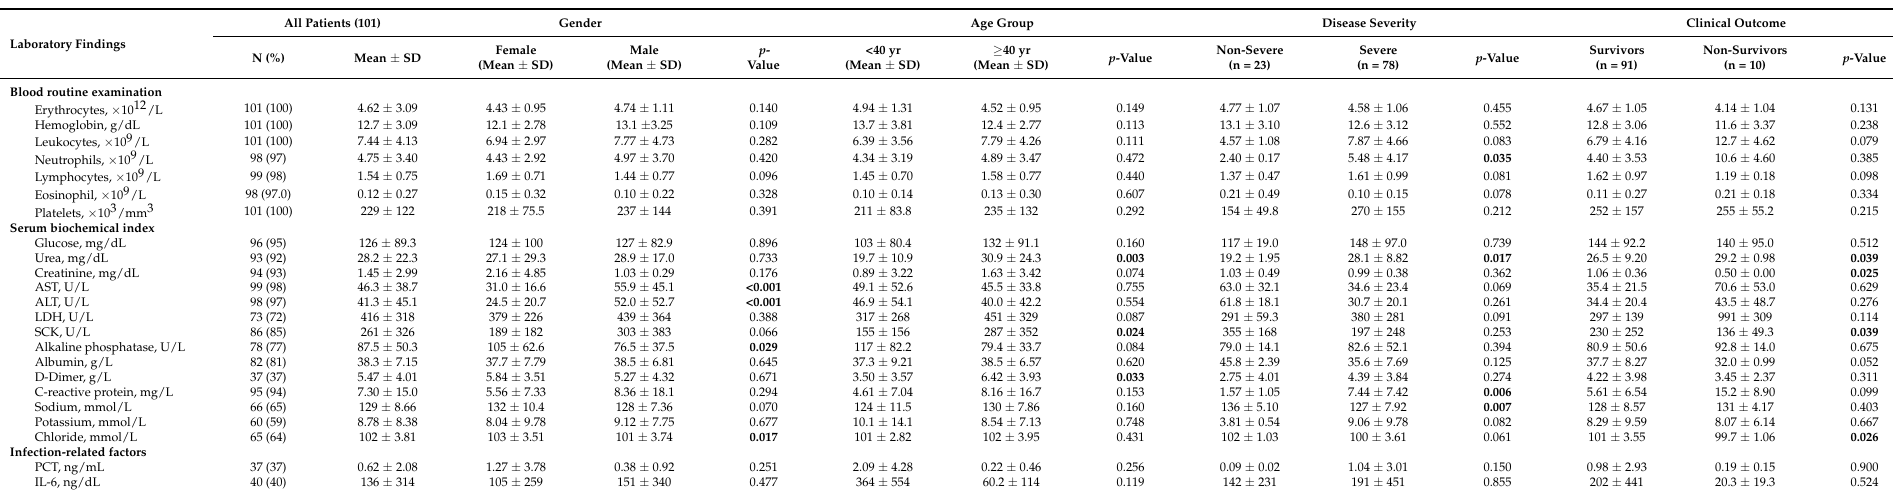
Table 2. Baseline laboratory parameters related to disease severity and clinical outcome among COVID-19 patients in Luanda, Angola.